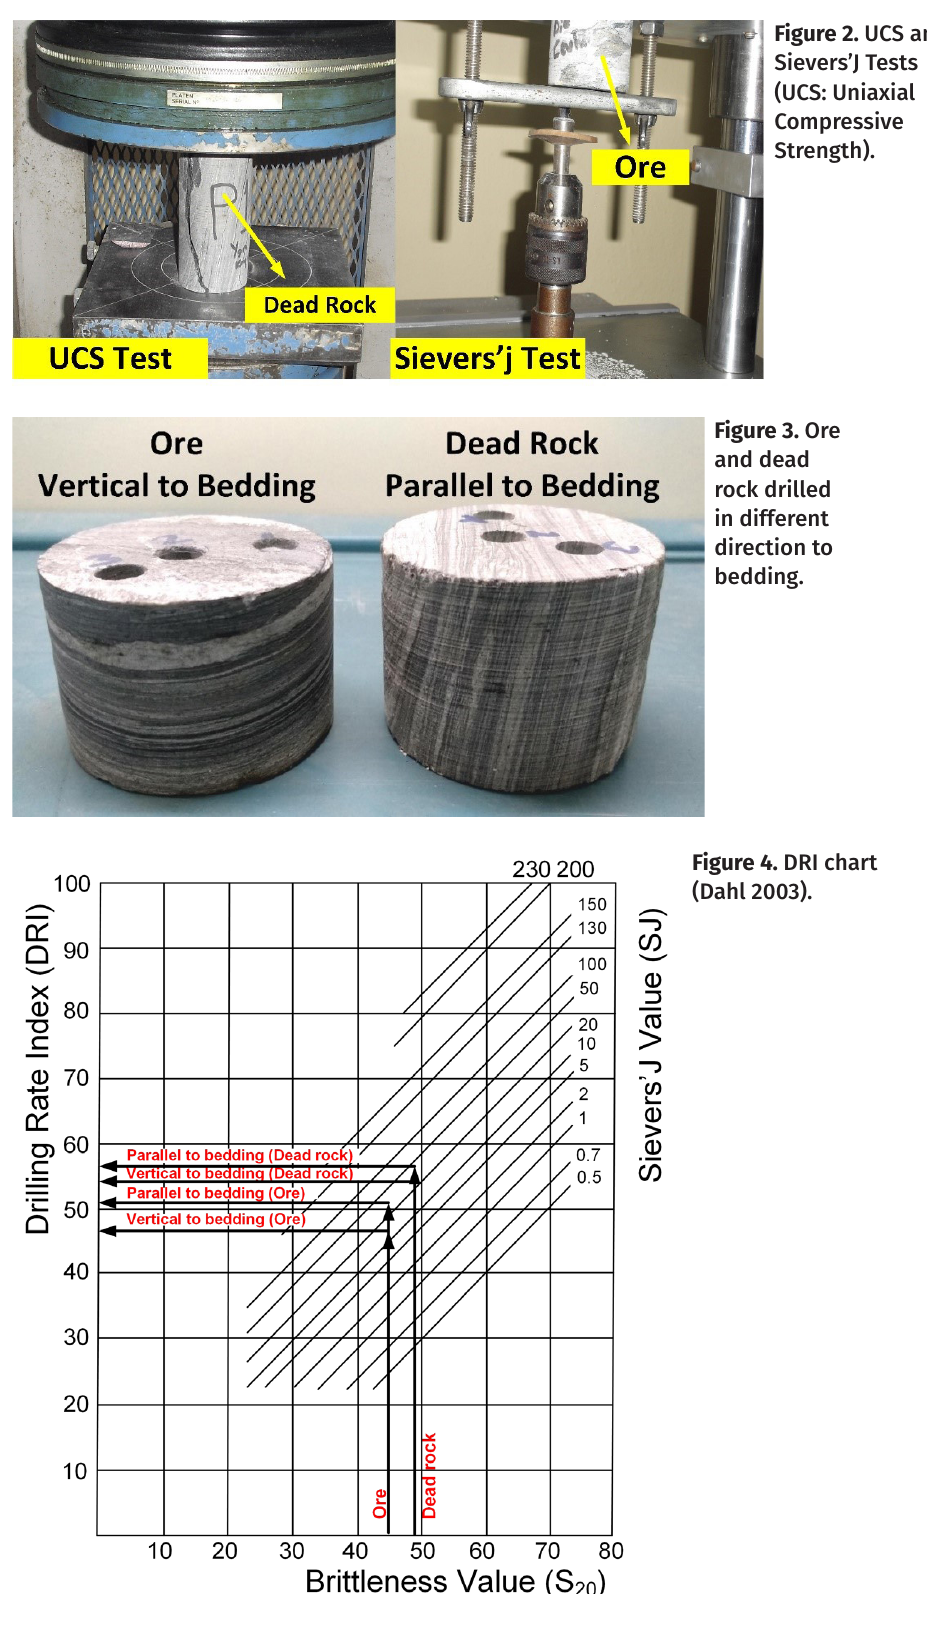
Figure 2. UCS and Sievers’J Tests (UCS: Uniaxial Compressive Strength).